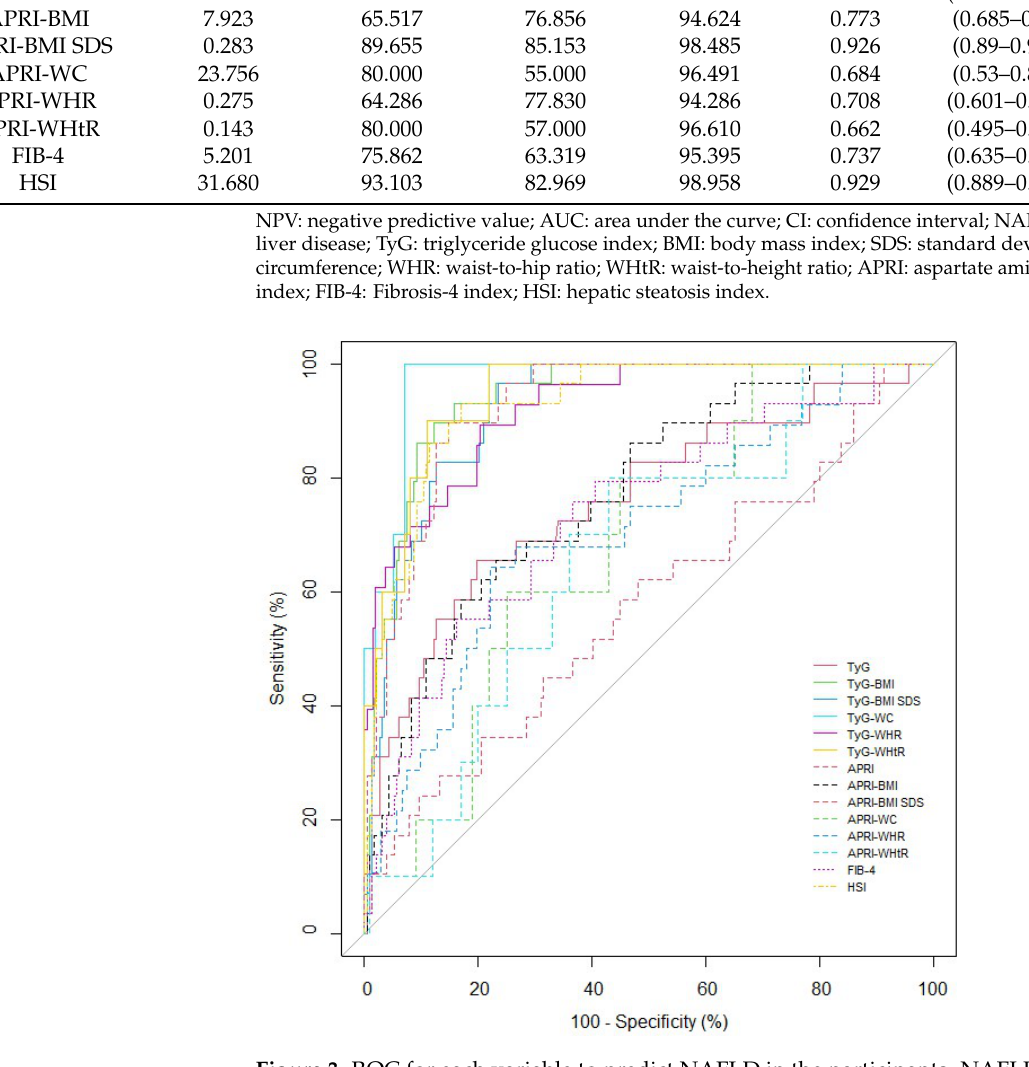
Figure 3. ROC for each variable to predict NAFLD in the participants. NAFLD, non-alcoholic fatty liver disease. TyG: triglyceride glucose index; BMI: body mass index; SDS: standard deviation score; WC: waist circumference; WHR: waist-to-hip ratio; WHtR: waist-to-height ratio; APRI: aspartate aminotransferase to platelet index; FIB-4: Fibrosis-4 index; HSI: hepatic steatosis index.